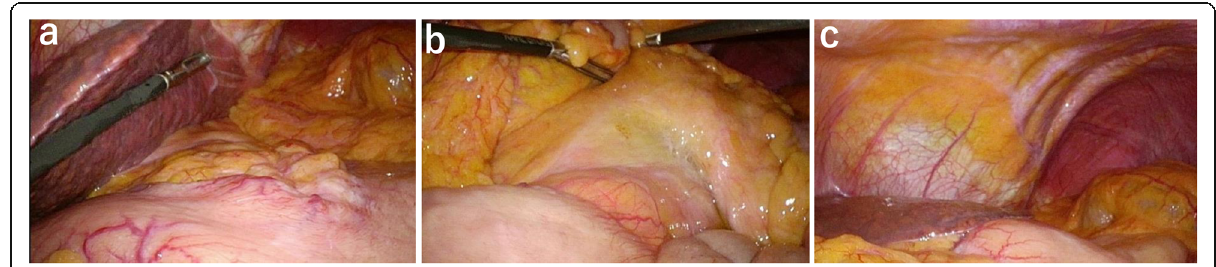
Fig. 4 Laparoscopic images after combined therapy. a Disappearance of bulky regional lymph nodes metastases. b Invasion of the transverse mesocolon is not seen. c There are no disseminated nodules in the abdominal cavity